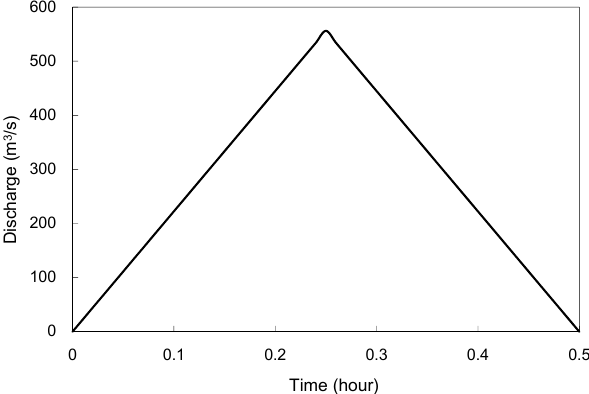
Figure 16. Surface water inflow hydrograph for debris flow runout simulation.